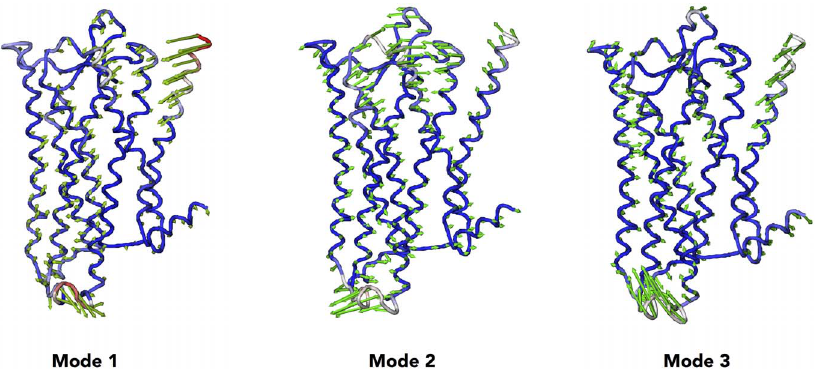
Fig. 11. Vector field representation of the three first principal modes obtained from the 0.5 m s all-atom MD simulation of the m OR structure.